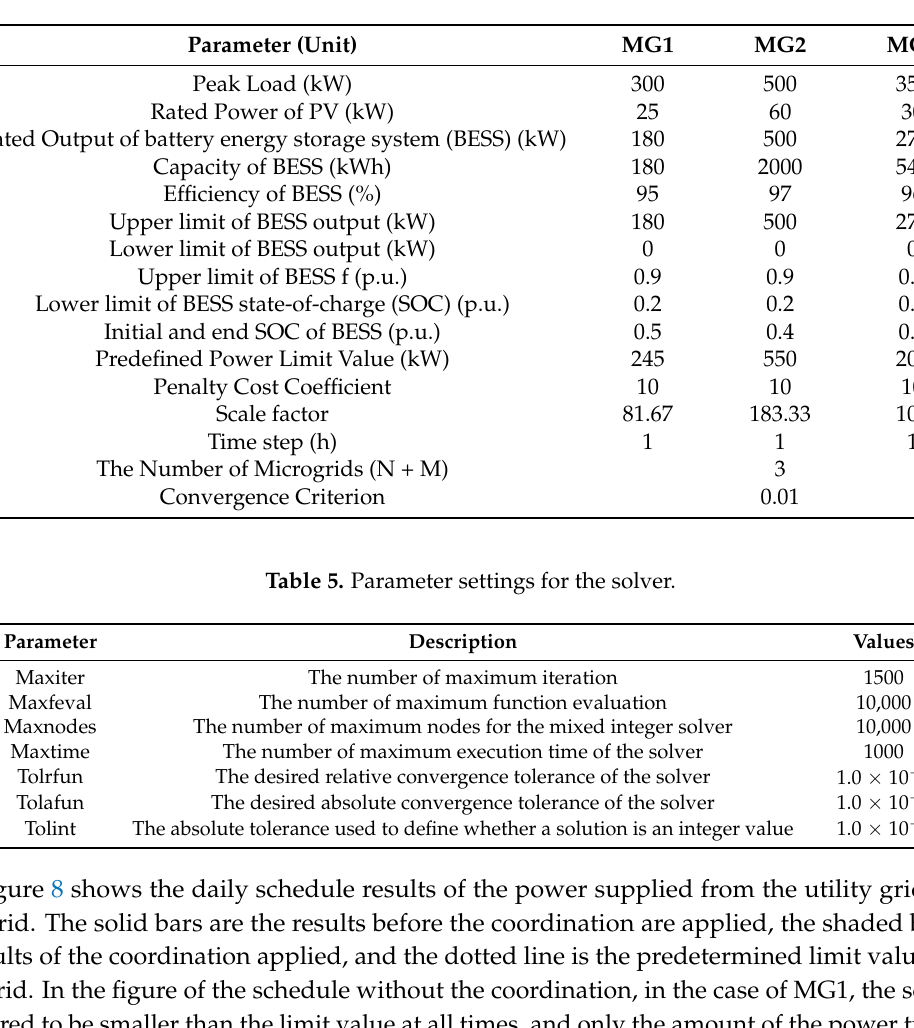
Figure 7. Load profiles of each microgrid. Table 4. Parameter setting of each microgrid.